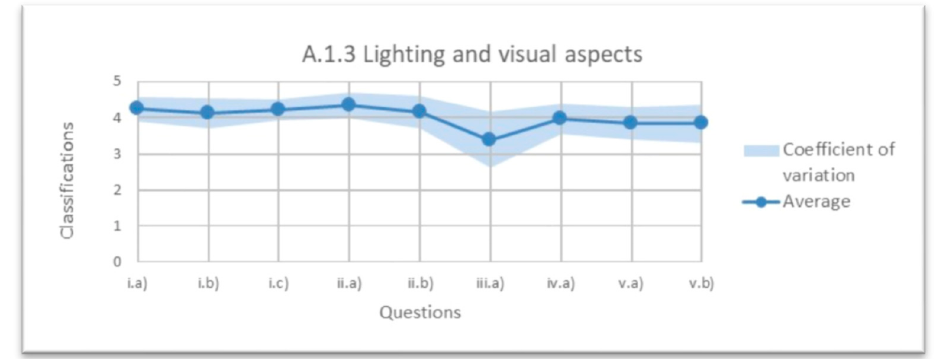
Figure 3. Average ratings of acoustic comfort.